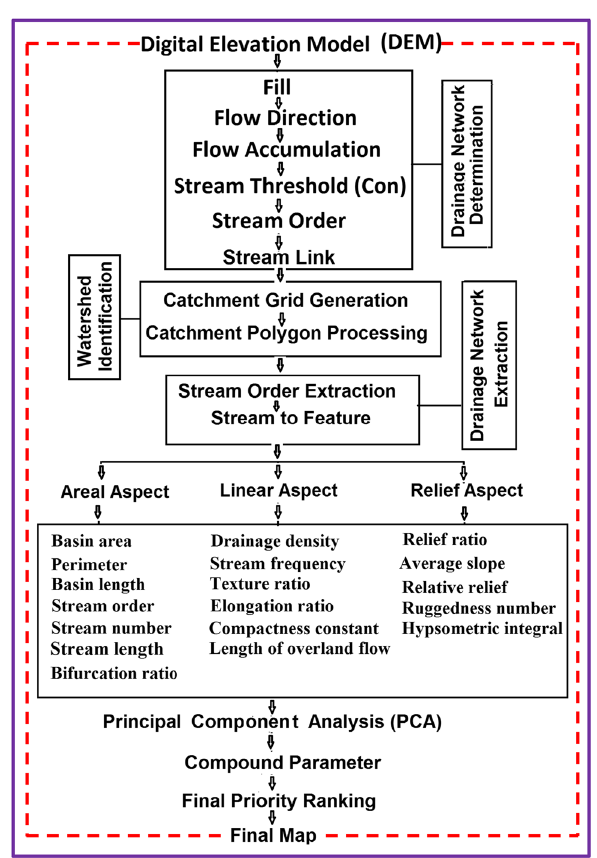
Fig. 6 Workflow for the whole